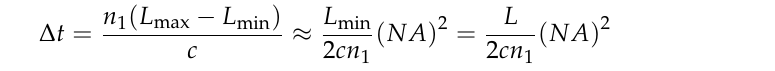
Figure 5. The inter-modal dispersion of the multi-mode gradient-index fiber.